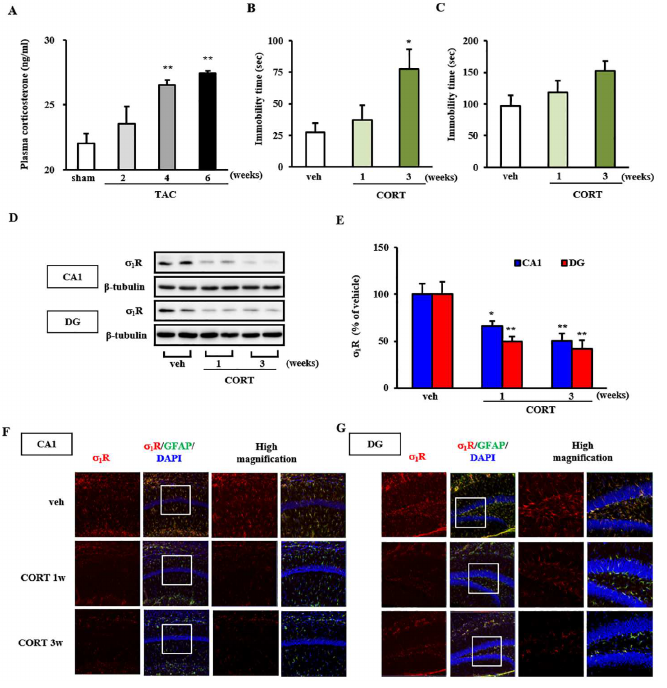
Fig 4. Effect of TAC surgery on plasma CORT levels. A: Measurement of plasma CORT levels in TAC mice. F (3, 21) = 16.602, P < 0.01. B: Immobility time in a forced swimming test was measured after 1 and 3 weeks of chronic CORT treatment. F (2, 24) = 4.193, P < 0.05. C: Immobility time in a tail suspension test was similarly measured. Groups consisted of 8–11 mice. F (2, 24) = 2.224, P = 0.130. D: Western blot analysis of σ 1 R and β -tubulin (as a loadingcontrol) proteins in the CA1 region and dentate gyrus (DG) of vehicle and CORT treated-mice. Immunoblotting with anti- β -tubulin antibody indicatesequal protein loading. E: Densitometric quantification of σ 1 R immunoreactivity (n = 6). Columns represent means ± S.E.M. F (2, 15) = 8.877, P < 0.01 (CA1); F (2, 15) = 10.614, P < 0.01 (DG). In A, B and E, * , P < 0.05 and ** , P < 0.01 versus sham- operatedmice or vehicle-treated mice. F: Immunofluorescencestaining showinglocalizationof σ 1 R (red) with the astrocyte marker GFAP (green) and DAPI (blue) in CA1. G: Similar analysisin the DG. Boxed regionsin F and G are magnifiedin adjacent right-hand